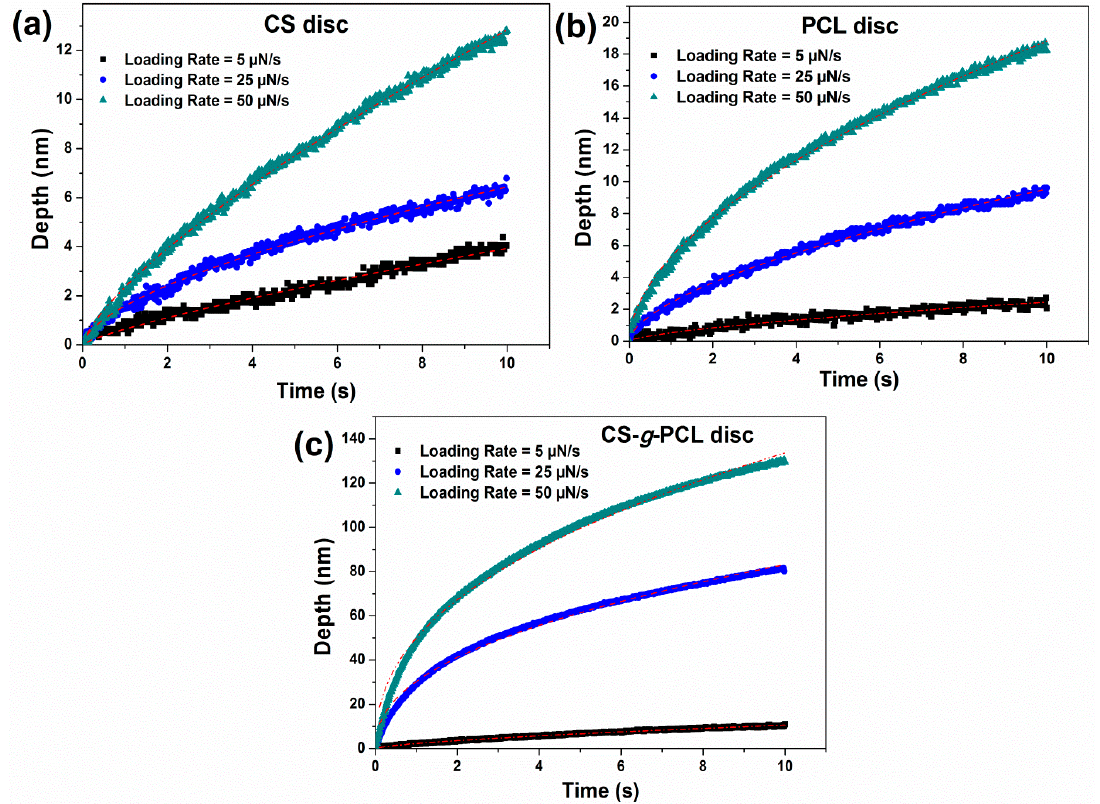
Figure 10. Evolution of penetration depth as obtained at different loading rates and at a constant applied load, as a function of time, for the ( a ) PCL; ( b ) CS; and ( c ) CS- g -PCL samples.